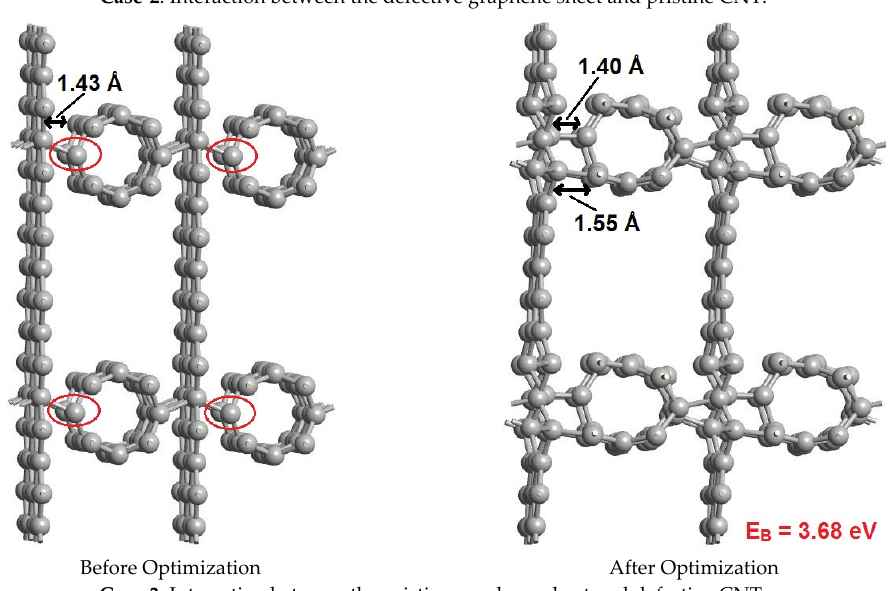
Figure 6. Interactions between pristine as well as defective graphene sheets and CNT.